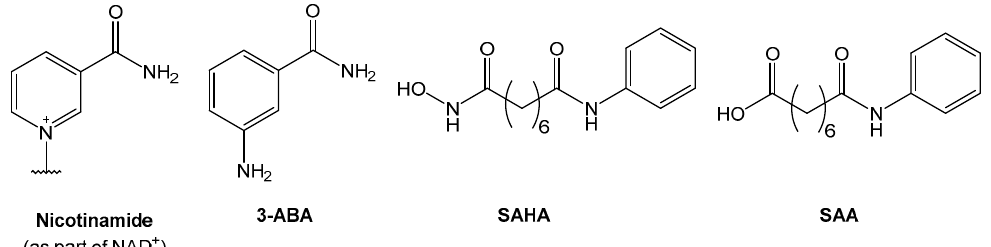
Figure 1. Sketch of the nicotinamide part of NAD + and some molecules cited in the text (3-aminobenzamide, 3-ABA ; suberoylanilide hydroxamic acid or vorinostat, SAHA ; 8-oxo-8-(phenylamino)octanoato, SAA ).